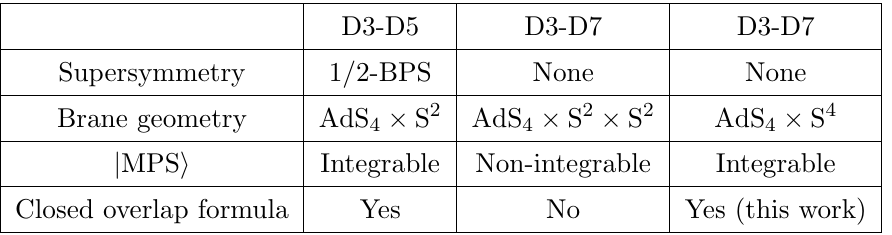
Table 1 . The dCFT versions of N = 4 SYM theory with non-vanishing vevs and their dual string theory con(cid:12)gurations. The discussion of the integrability properties of the corresponding matrix product states can be found in [13, 14] and the closed expression for the overlap formula for the D3-D5 case appears in [9{11, 13] for tree level and in [26] for one-loop, see also [27,